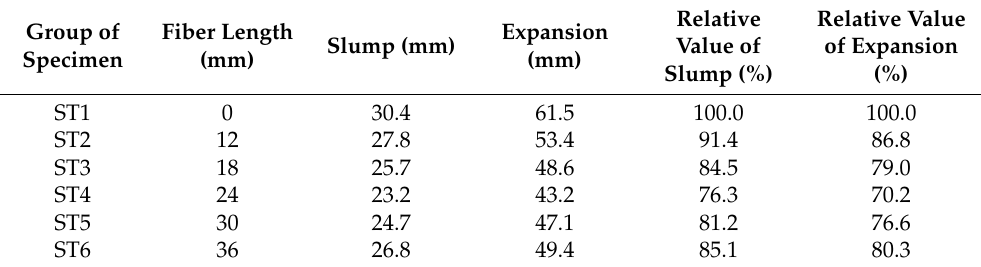
Table 4. The slump test results of the BRFC with different fiber volume contents. Group of